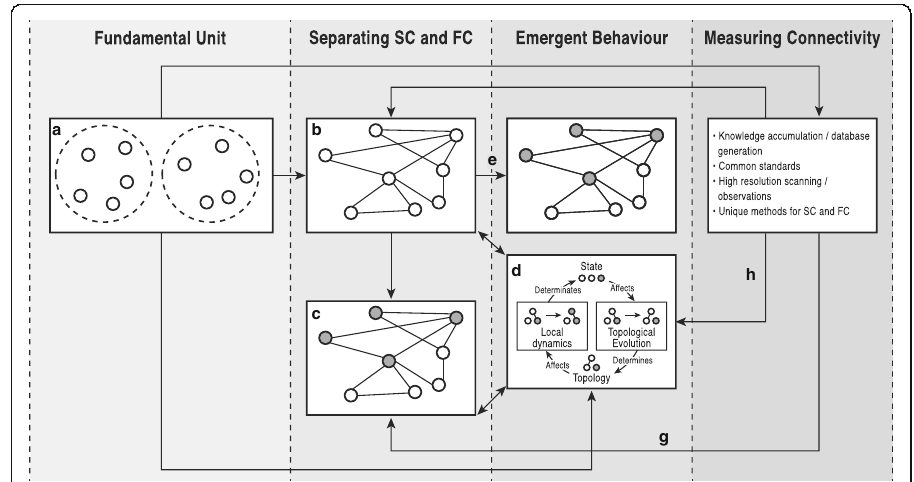
Fig. 6 Network-centred common toolbox. Diagram showing how a network-centred common toolbox implicitly addresses the four (inextricably linked) key challenges: defining the fundamental unit, separating SC and FC, understanding emergent behaviour and measuring connectivity. A. Groups of nodes form fundamental units at higher levels of organization (denoted by grey dashed lines); B. Topological representation of system structure (spatially embedded depending in the system in question); C. Identifying parts of the network that are dynamic (functionally connected); D. Adaptive network where the evolution of topology depends on the dynamics of nodes (source: Gross and Blasius; 2008). Network adaptation at multiple (cross scale) levels of organization shapes emergent behaviour; E. FC may have an emergent aspect (self-organised, collective patterns on the structural network) that is independent of network adaptation; F. The fundamental unit should dictate the measurement approach; G. Measurements of SC and FC should be used to parameterise and test network-based representations; H. How we measure connectivity determines our ability to detect how connectivity leads to emergent